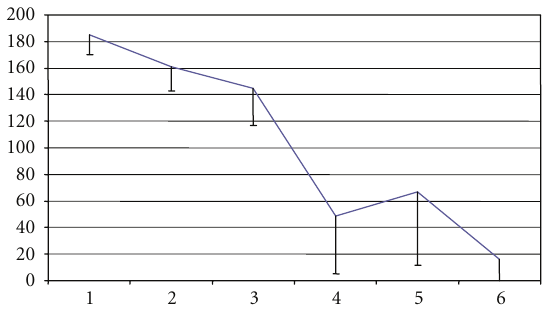
Figure 2: E ffl uent CA125U/min means by time (years on PD) estimated by repeated measurements mixed model analysis ( P = 0 .